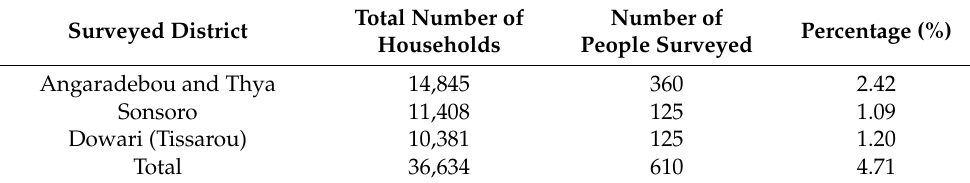
Table 2. Characteristics of the sample used.